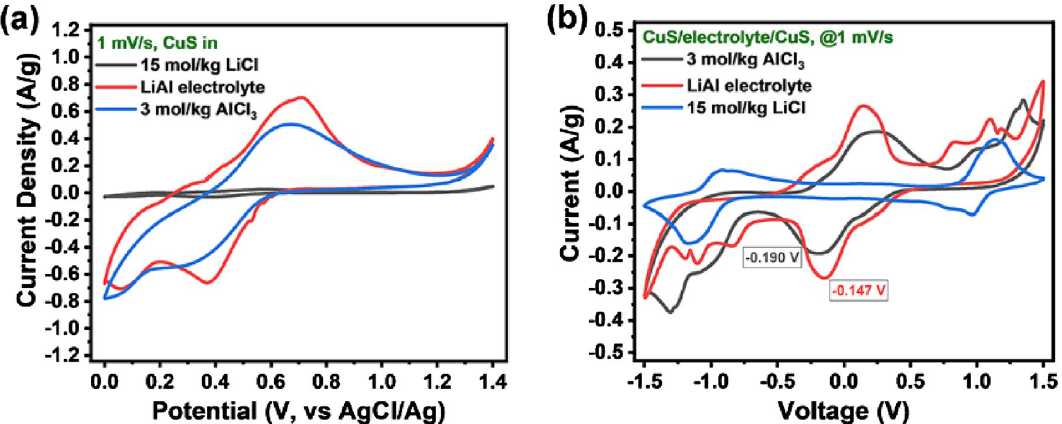
Figure 2. Electrochemical Al-storage performance of CuS electrodes: CV tests of ( a ) 3-electrode system and ( b ) symmetric battery in different